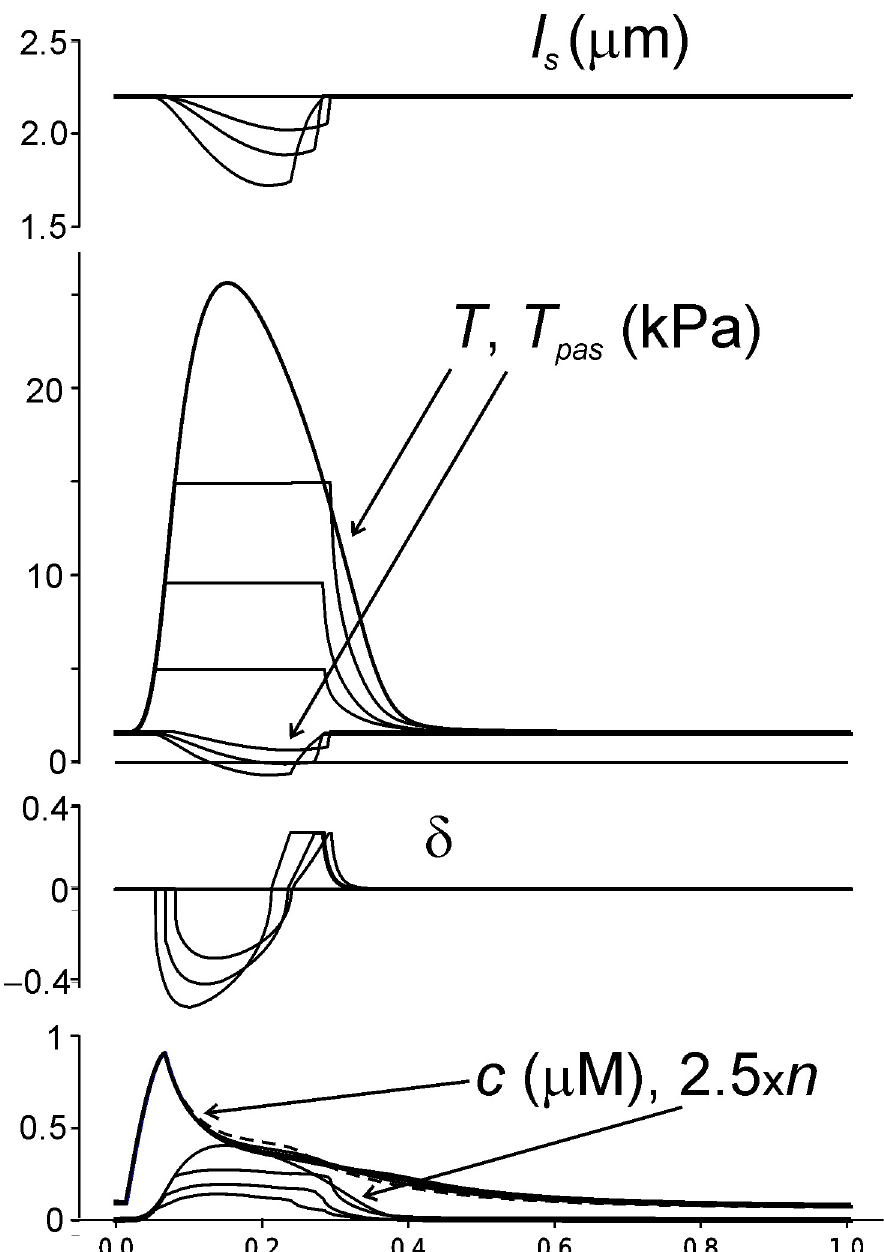
Fig 7. The results of simulation of isotonic contractions under different load. From top to bottom: sarcomere length, total and passive tension, δ , c , and n multiplied by a factor 2.5. Ca 2+ -transient c for isometric contraction is shown by dashed